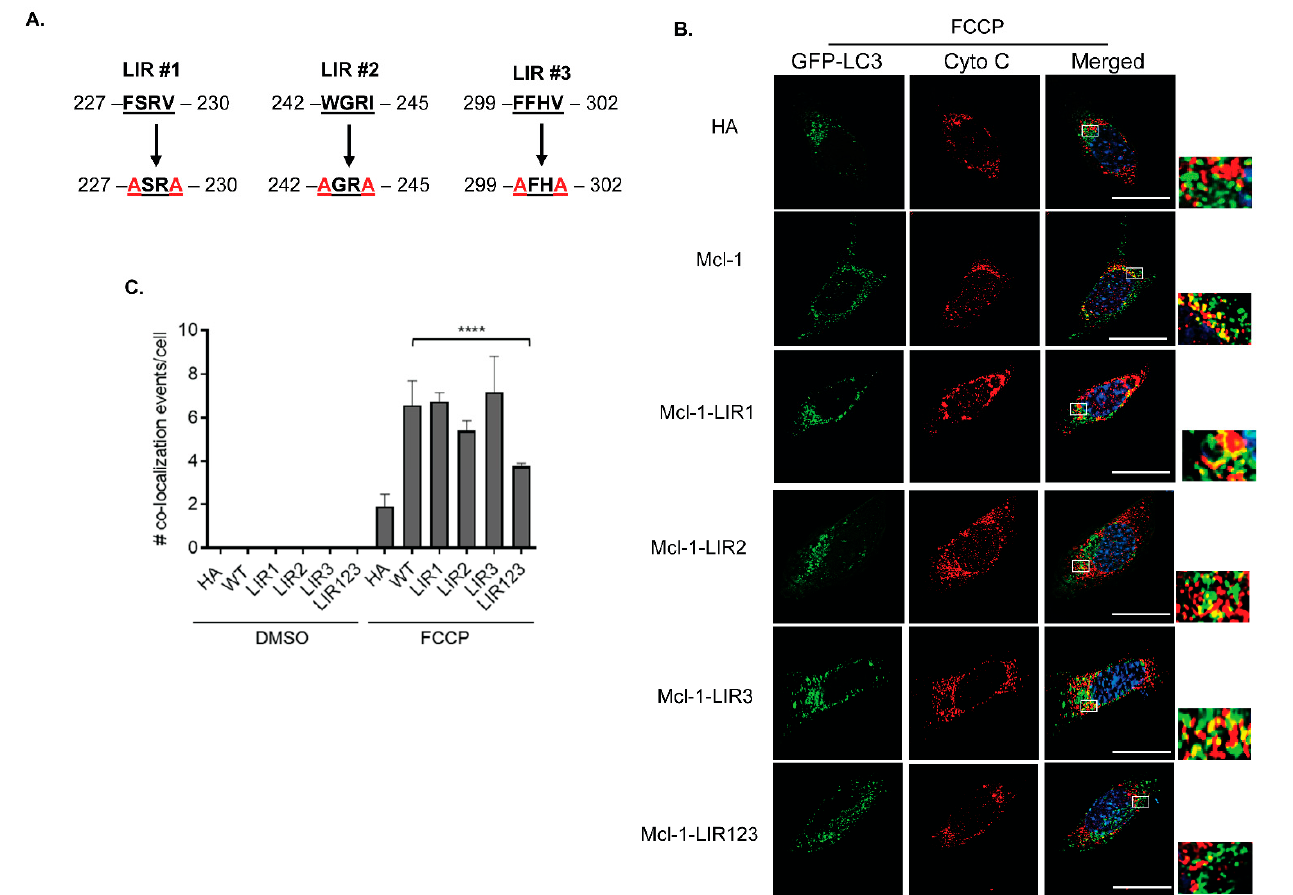
Figure 5. Mcl-1 -mediated mitophagy is partially dependent on its LC3-interacting region (LIR) motifs. ( A ) Mutation of Mcl-1 ’s putative LIR motifs. ( B ) Representative fluorescence images of GFP-LC3 and Cytochrome c colocalization in cells overexpressing HA, Mcl-1 , or Mcl-1 LIR mutants. ( C ) Quantifica- tion of colocalization events between autophagosomes and mitochondria after treatment with 25 µ M FCCP ( n = 3–6, 18–20 cells were scored in each experiment). **** p < 0.0001. Data are mean ± SEM. Scale bar = 20 µ m. Statistical test: ANOVA, followed by Bonferroni’s multiple comparison test.